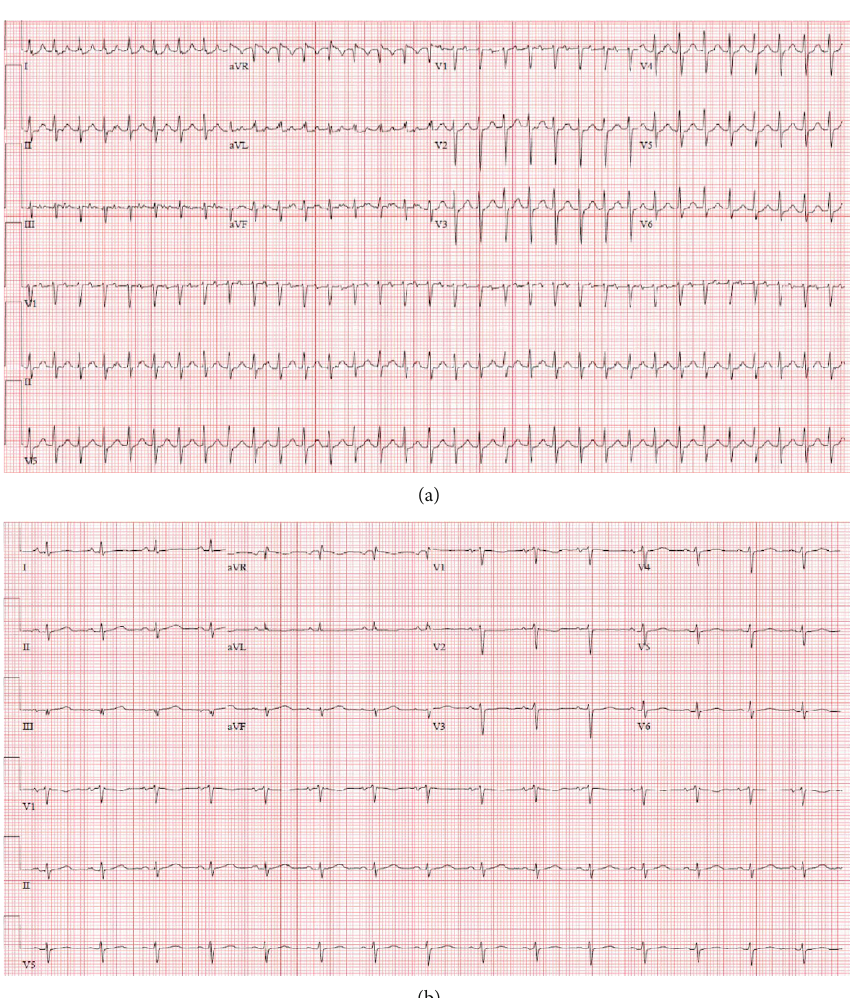
Figure 1: EKG before (a) and after (b) pericardial lipoma resection. (a) Findings: supraventricular tachycardia (197bpm) with low voltage QRS. (b) Findings: normal sinus rhythm (91